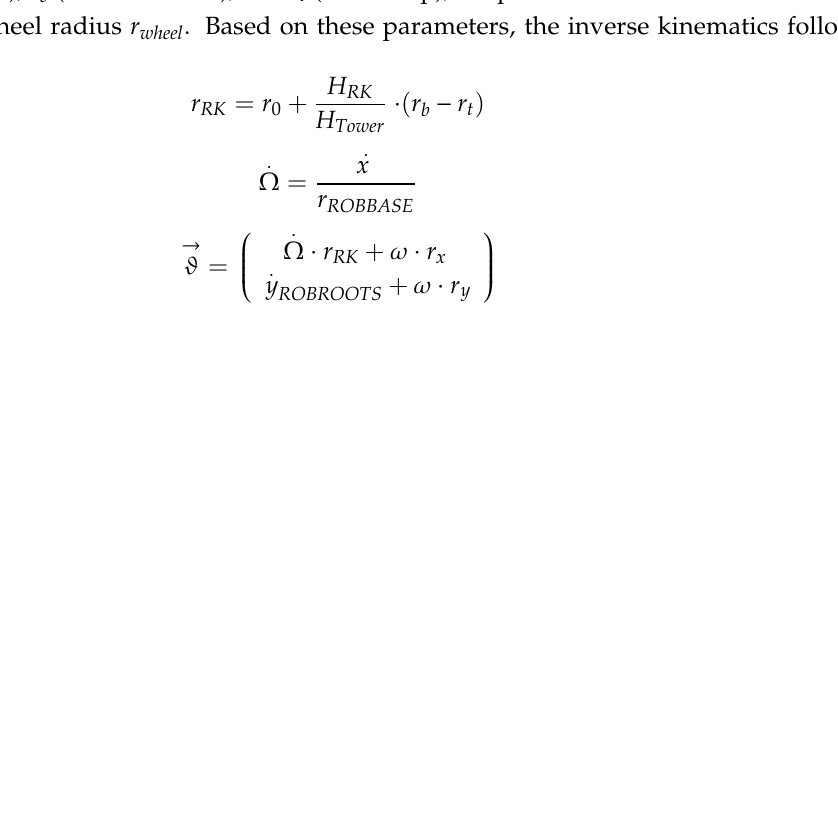
Figure 18. Tower coordinate frame.